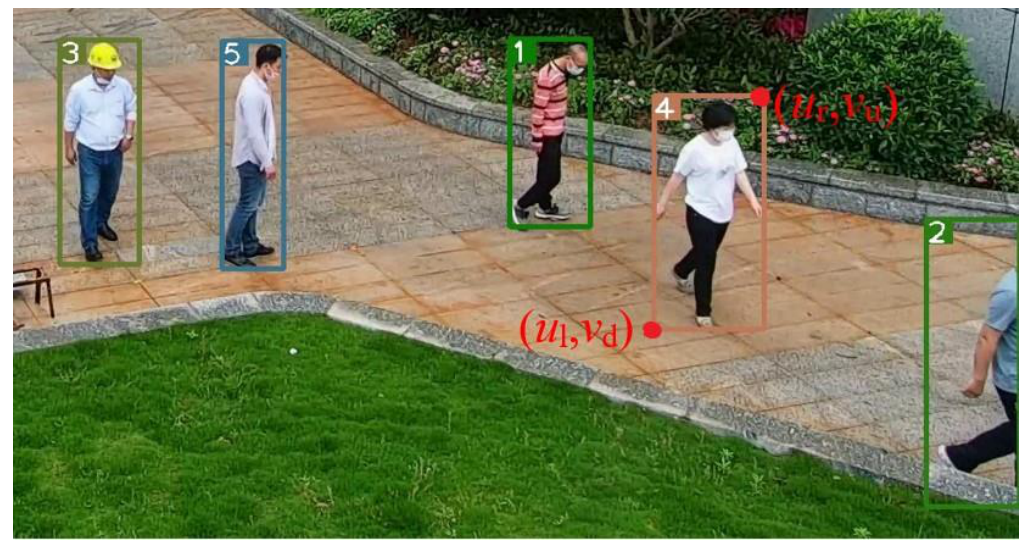
Figure 4. Results of object tracking. Numbers 1, 2, 3, 4, 5 are object IDs in this image. The size and position of the bounding box are ( u l , v u , u r , v d